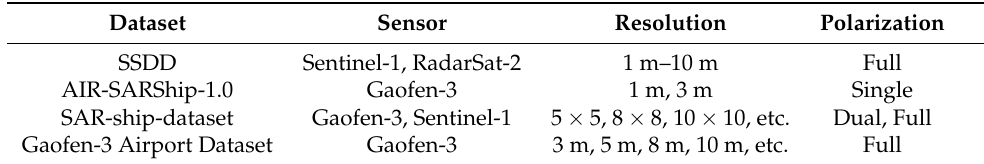
Table 1. Detailed descriptions of several open SAR